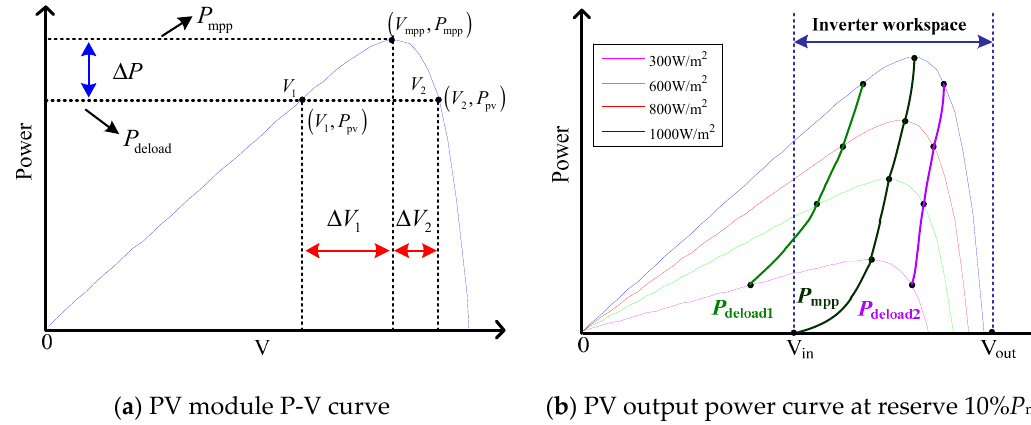
Figure 3. PV-PRC voltage operating point diagram.